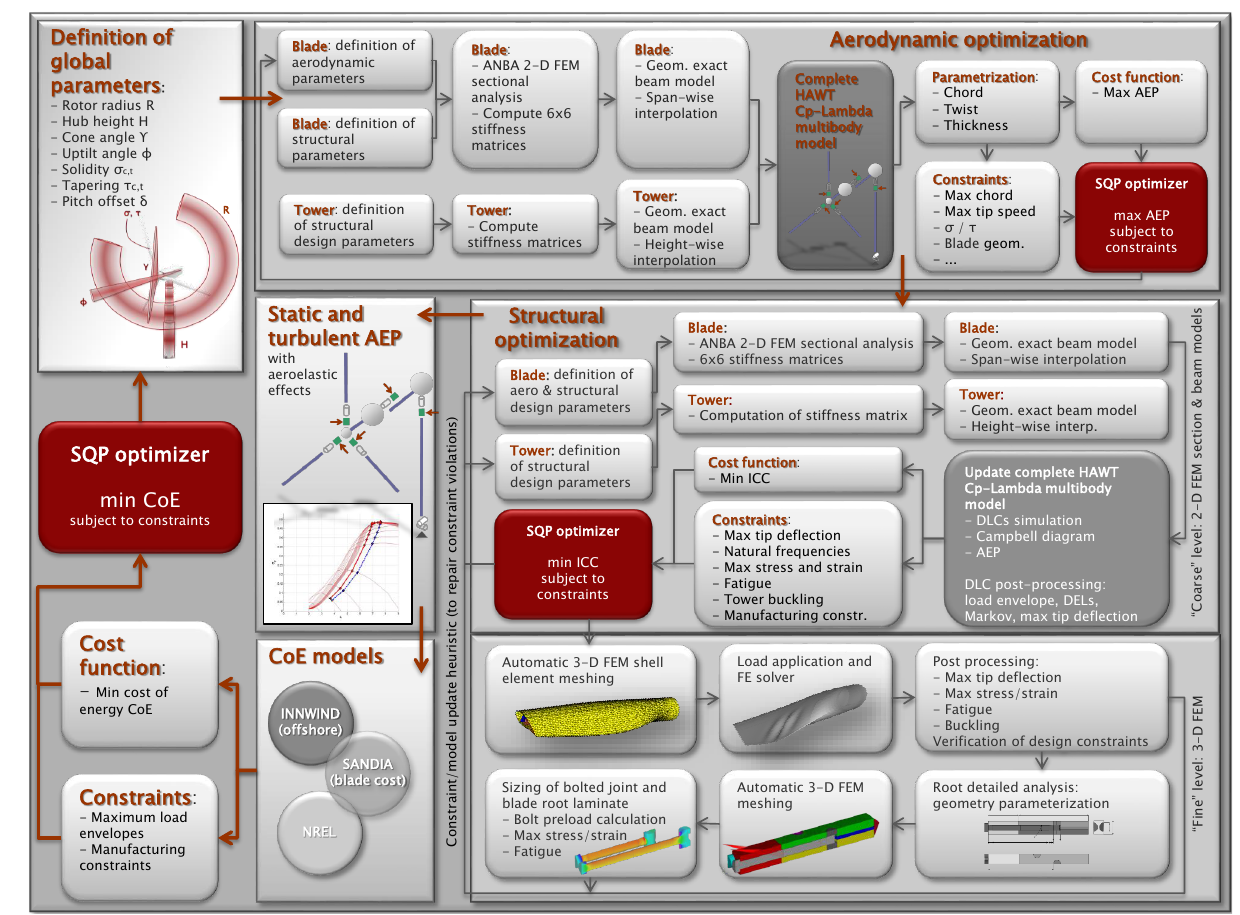
Figure 1. Overall architecture of the multi-level combined preliminary–detailed design